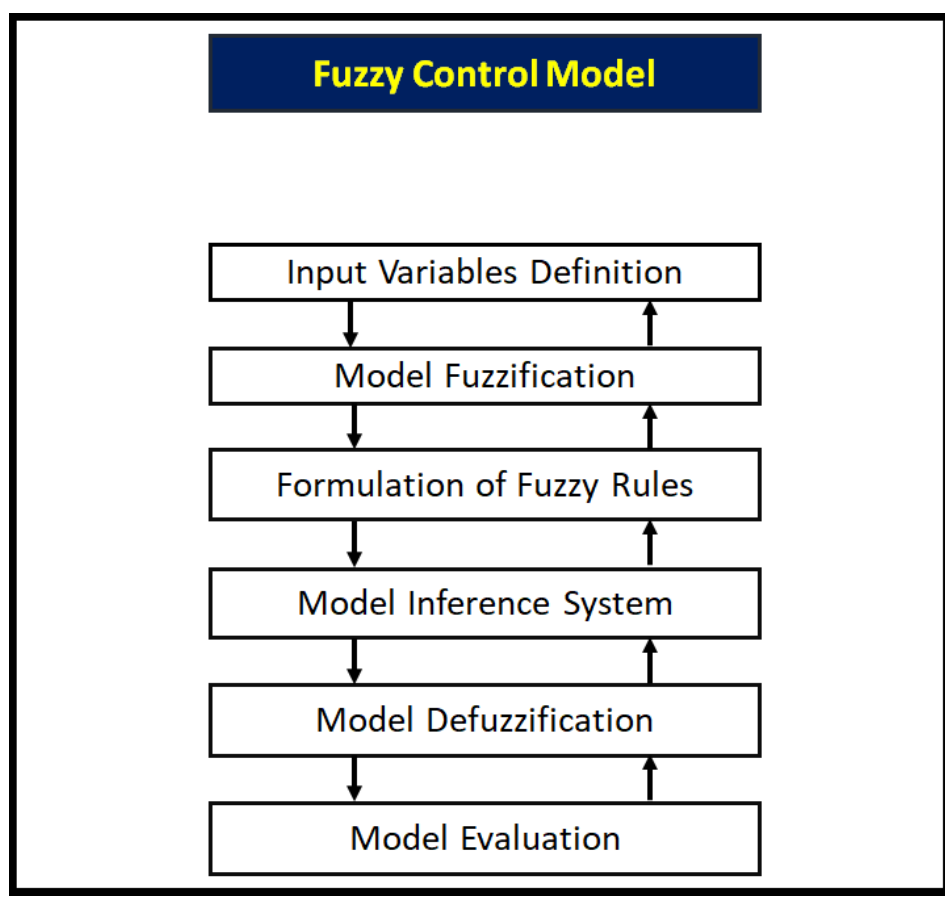
Figure 1. Main components of fuzzy model